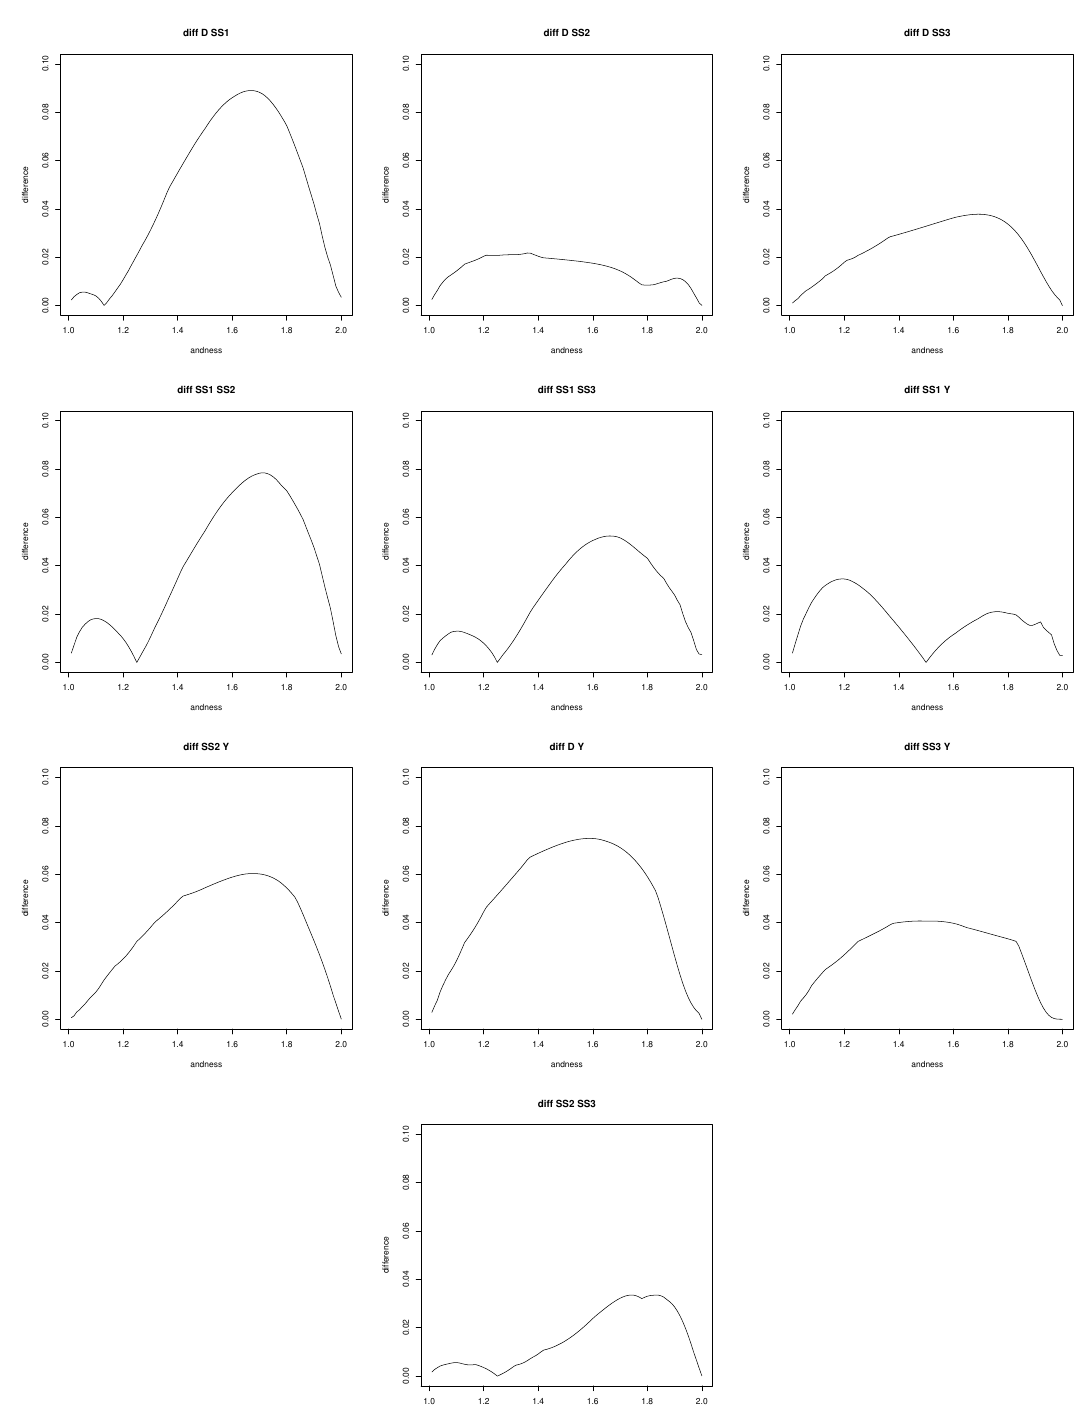
Figure 4. Given andness α , difference between pairs of t-norms T D , T SS 1 , T SS 2 , T SS 3 , T Y . Their parameters ( λ , p , or w ) have been selected so that the t-norm has precisely andness α (i.e., ( λ = λ ( α ) , p = p ( α ) , and w = w ( α )